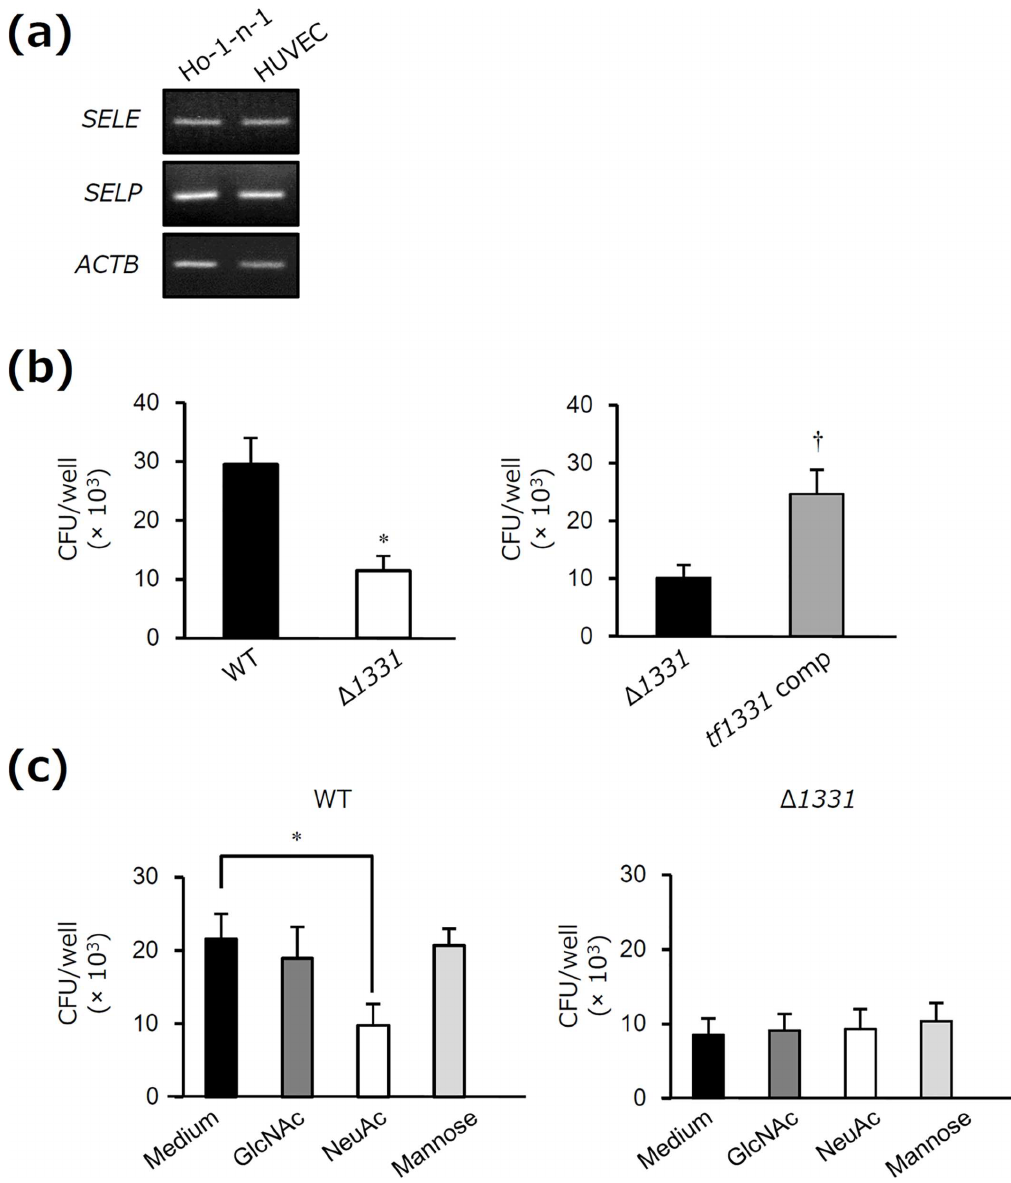
Fig 7. Sugar chains of OmpA-like protein mediate adhesion of T . forsythia to human oral epithelial cells. (a) Total RNA (1 μ g) was preparedfrom Ho-1-n-1cells and HUVECs to assess the expressionof SELE (E-selectin), SELP (P-selectin), and ACTB ( β -actin) by RT-PCR. HUVECs, which express E-selectin and P-selectin mRNA, were used as positive controls. The PCR products were visualizedon 1.5% agarose gels stained with ethidium bromide and photographed under UV light. The results are representative of three independent experiments. (b) WT, Δ 1331 or Δ 1331 complemented with tf1331 ( tf1331 comp) was added to Ho-1-n-1 cells at a m.o.i. of 100 for 3 h. At the end of the incubationperiod, the cells were washed three times with PBS and lysed by incubationin sterile water for 20 min. Cell lysates were serially diluted in sterile PBS and cultured on supplemented blood agar plates. The number of viable adherent bacteria was determinedby counting the coloniesthat appeared.The results are expressed as the mean ± SD (n = 3). * , P < 0.05 for comparison with WT. † , P < 0.05 for comparison with Δ 1331 . (c) Ho-1-n-1cells were preincubated with and without 200 mM GlcNAc, 200 mM NeuAc, and 10 mM mannose for 2 h. Then, WT or Δ 1331 was added at a m.o.i. of 100 for 3 h, and the number of viable adherent bacteria was determined. The results are expressed as the mean ± SD (n = 3). * , P <